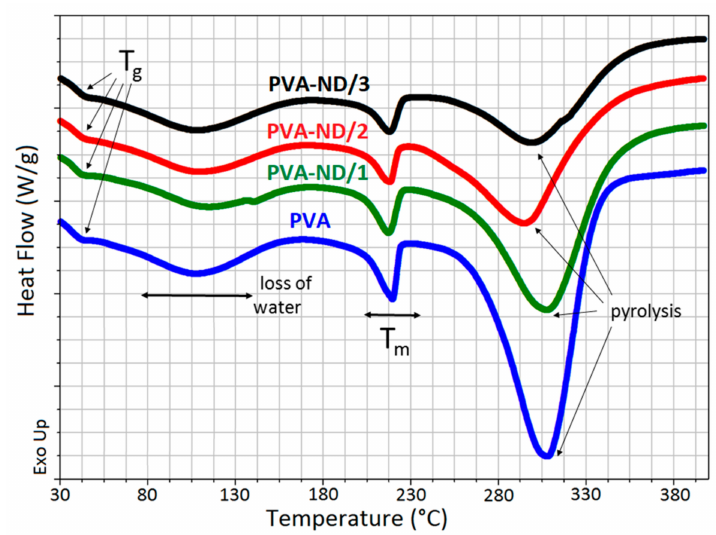
Figure 9. DSC curves of the pure PVA film and the PVA-ND nanocomposites. The endothermic heat of fusion at ~218 ◦ C was used to determine the crystallinity ( X c ) of PVA and the nanocomposites (Table 3). The X c of the polymers was determined from DSC curves using Equation (1), supposing a linear relationship between the endothermal